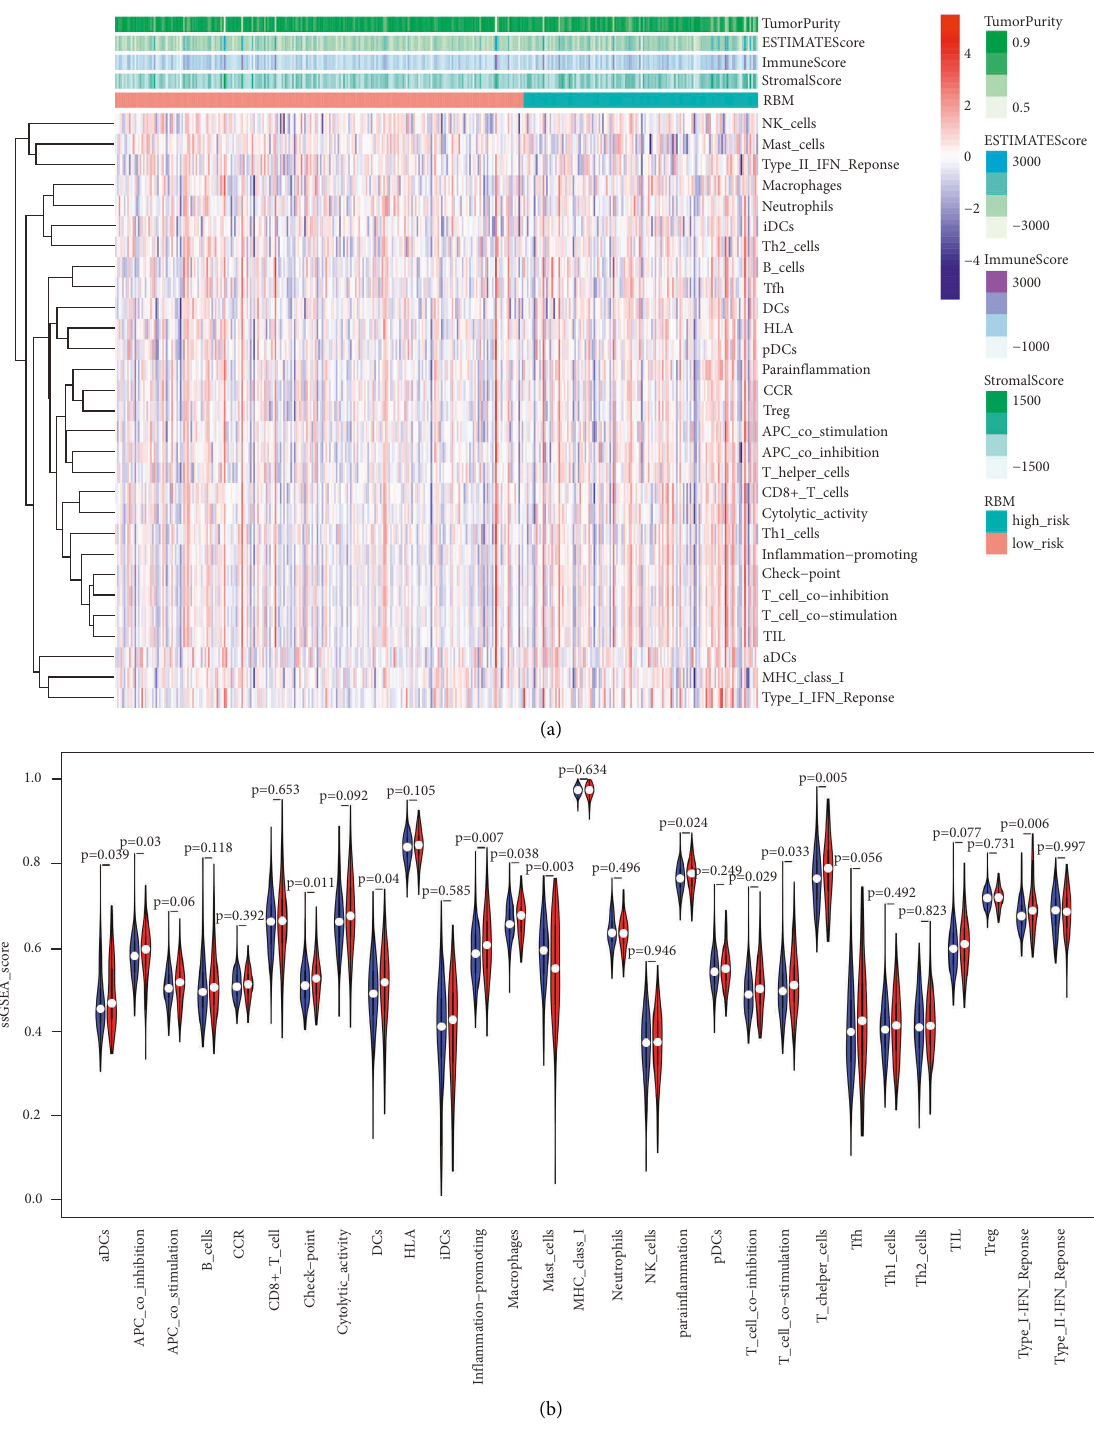
Figure 6: Relationship between immunological microenvironment and the odds of bone metastasis. (a) A hierarchical clustering analysis of 367 TCGA prostate cancer samples based on 29 immune-related gene sets. Tumor purity, ESTIMATE, immune, and stromal scores were determined using ESTIMATE. RBM: risk of bone metastasis. (b) ssGSEA score comparisons in the LRBM and HRBM cohorts for 29 immune-related gene sets. ∗ P < 0 . 05, ∗∗ P < 0 . 01, ∗∗∗ P < 0 . 001; two-sided Mann–Whitney U